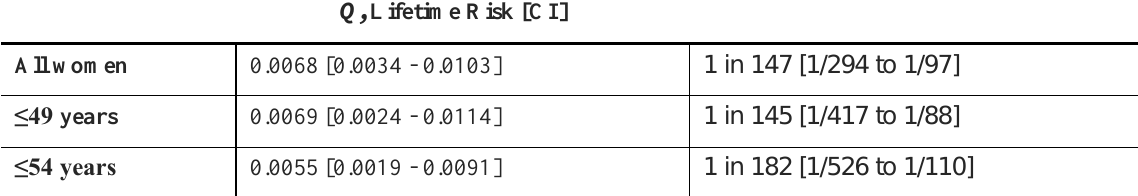
Table 2. Lifetime risk of maternal